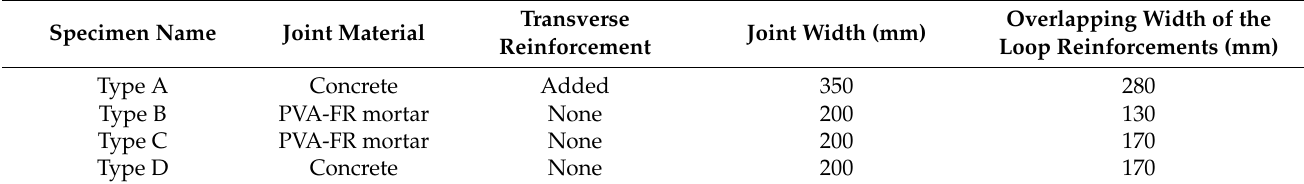
Table 3. Specifications of flexural loading test specimens.